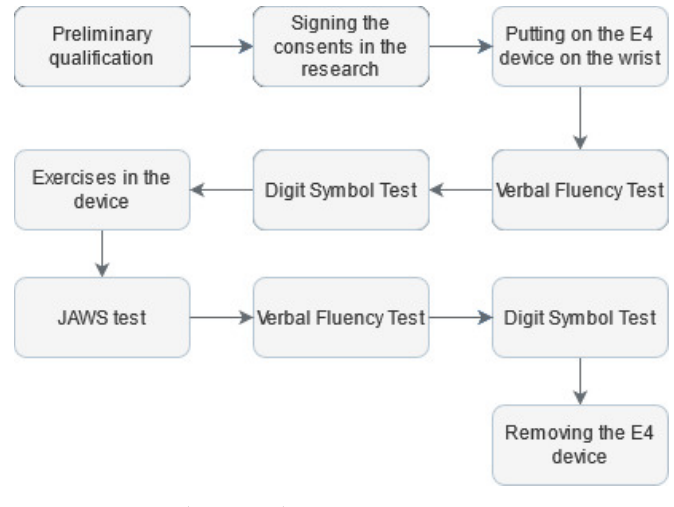
Figure 1. Research